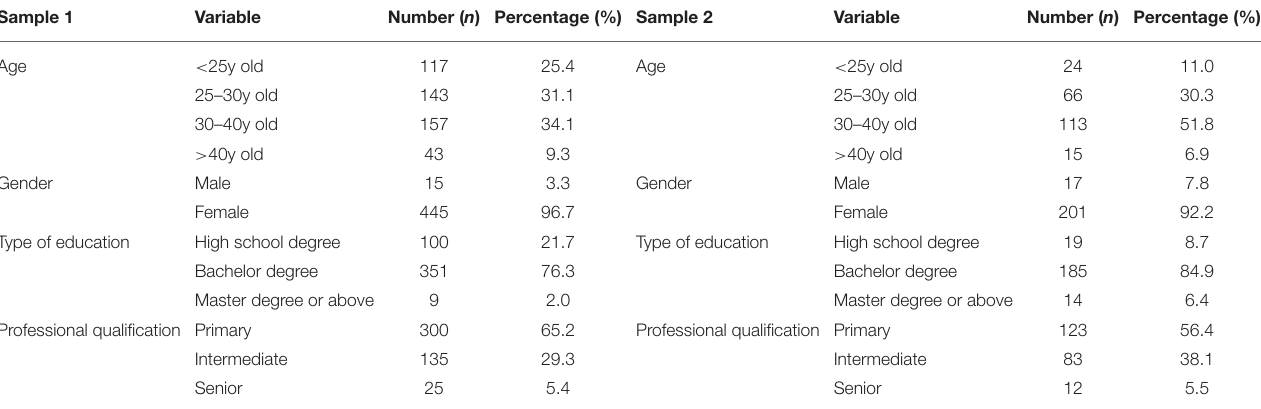
TABLE 1 | The personal and demographic information of the participating in the study. Sample